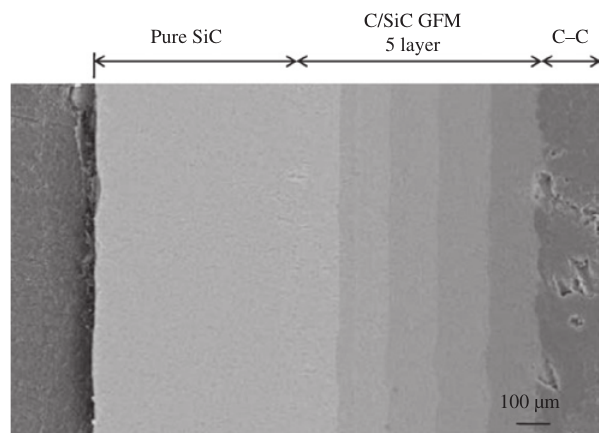
Figure 24: Image of the polished C/C composites coated with C/SiC FGM and SiC layers along the cross section [77].